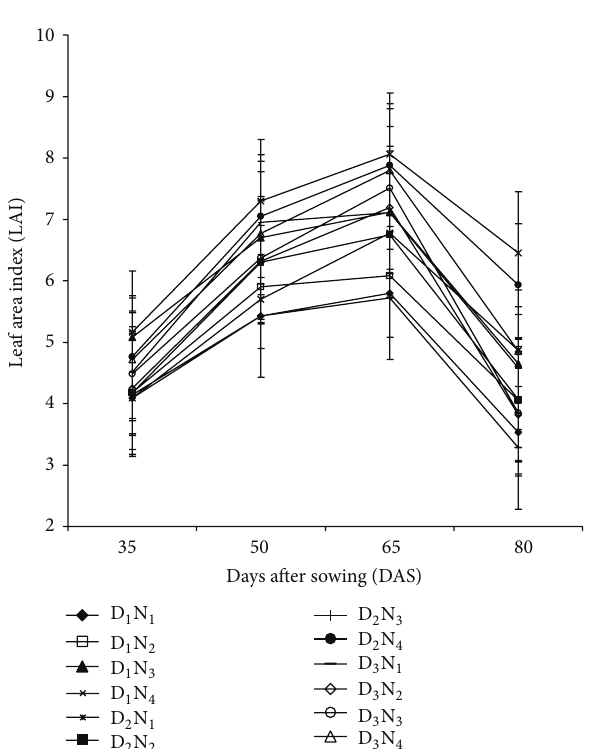
Figure 3: Light interception by maize canopy as affected by planting density and N-fertilizer application at different growth stages (D 1 = 53,000 plant/ha, D 2 = 66,000 plant/ha, D 3 = 80,000 plant/ha, N 1 = 100kg N/ha, N 2 = 140kg/ha, N 3 = 180kgN/ha, N 4 = 220 kg N/ha. Bar showed ± SE